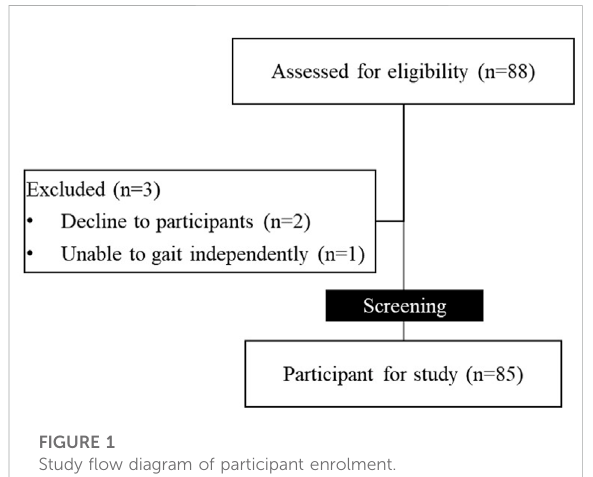
FIGURE 2 CT images of L3 skeletal muscle area measurement (red area represents skeletal muscle